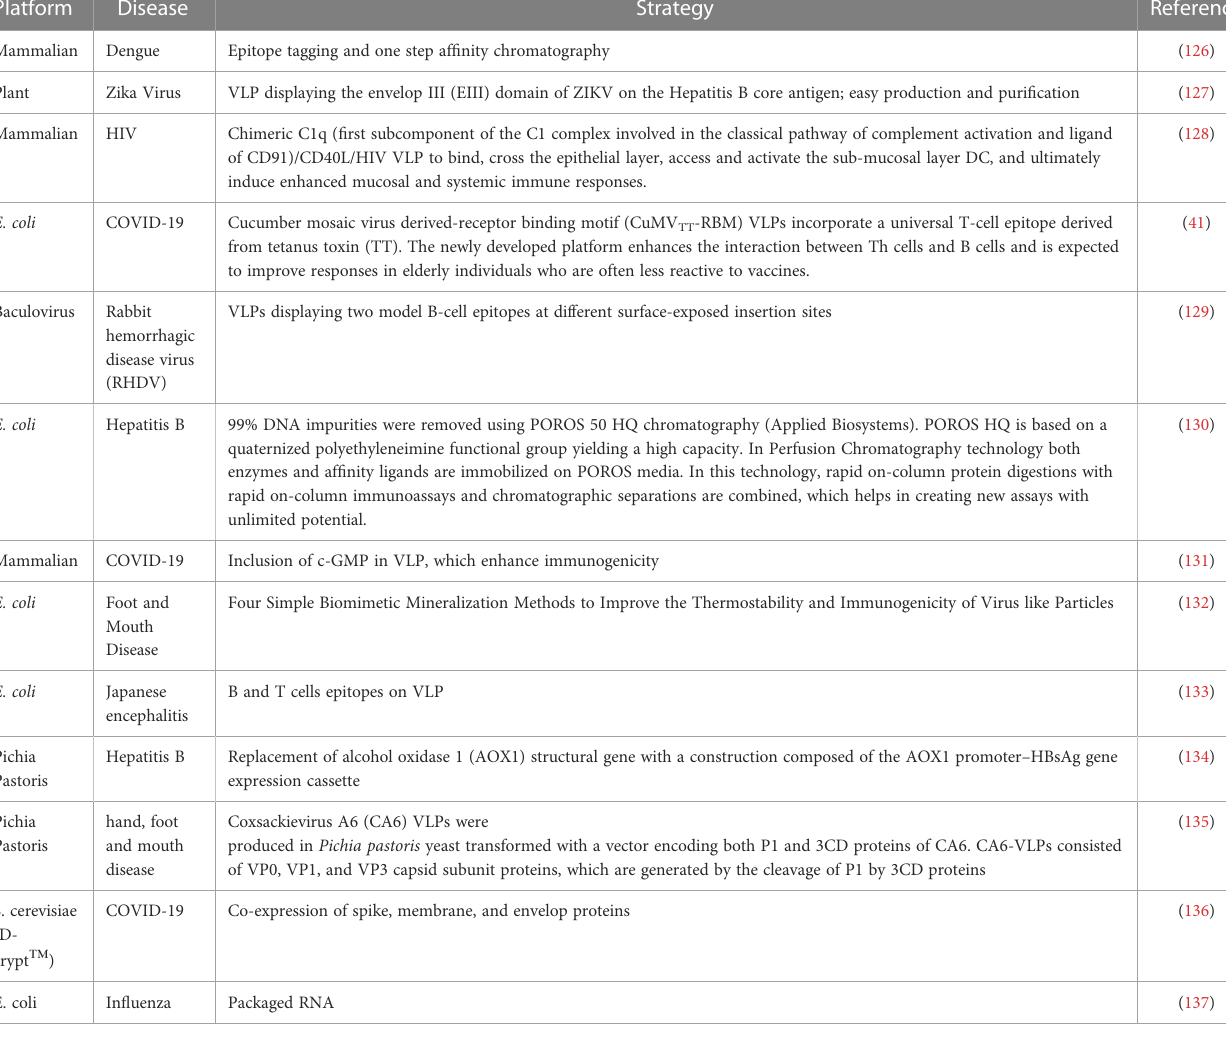
TABLE 4 Strategies to enhance productivity/immunogenicity of VLP. Platform